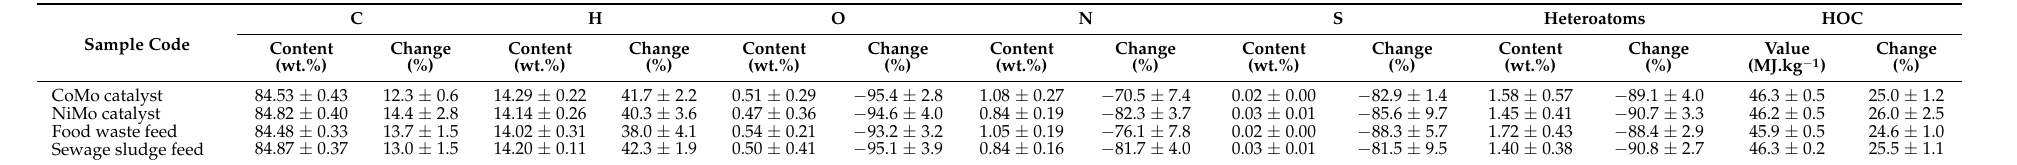
Table 5. Average elemental composition of the upgraded wet-waste HTL biocrudes obtained, and the changes observed relative to the starting material (grouped on variable of catalyst or feed